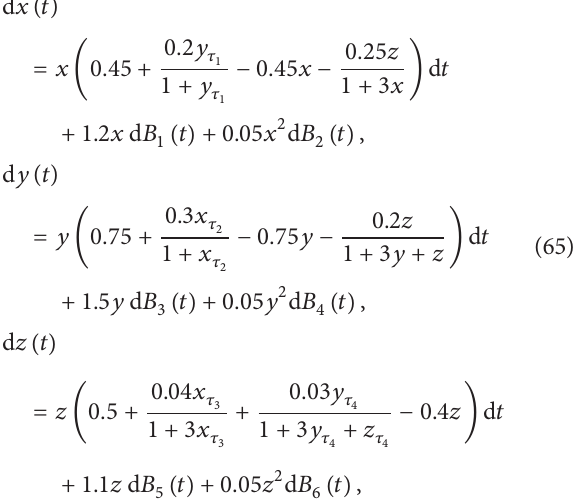
0.2𝑦 𝜏 1 − 0.45𝑥 − 1 + 𝑦 𝜏 1 (𝑡) + 0.05𝑥 2 d 𝐵 1